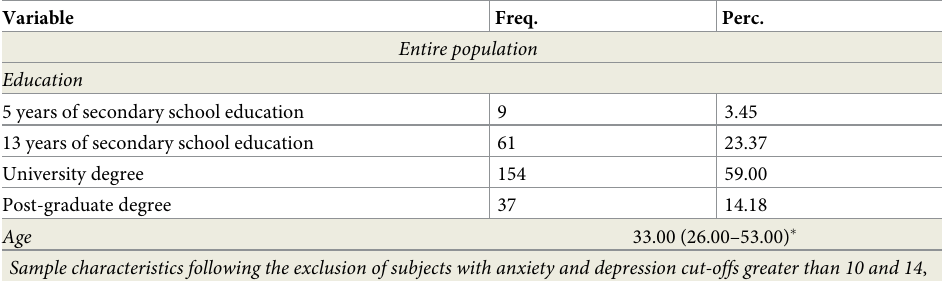
Table 1. Study 2 sample characteristics. Variable